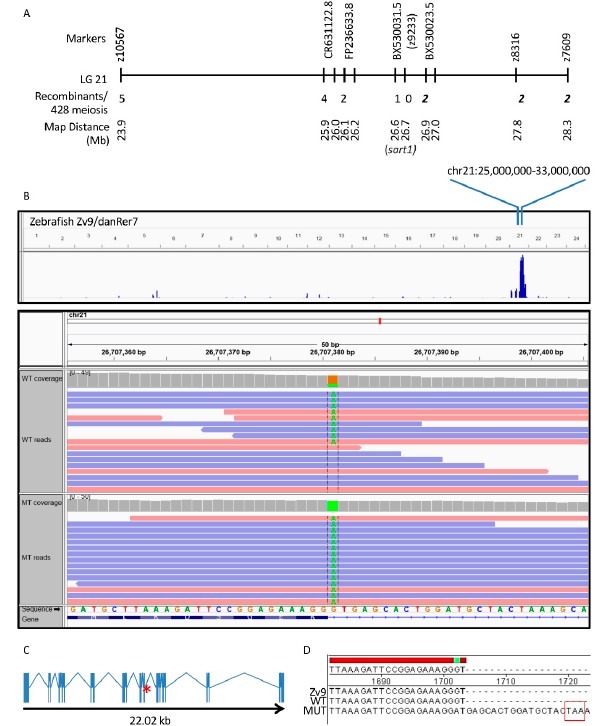
Figure 2. Positional cloning defines critical interval on chromosome 21 and WES identifies a point mutation in sart1 . ( A ) A critical interval was defined on Chromosome 21 using positional cloning. For bulked segregant analysis, the polymorphic marker z9233 demonstrated linkage having zero recombinants identified out of 450 meiotic events. Additional markers were analyzed both proximal and distal to z9233 to define a critical interval of approximately 0.4 Mb. The numbers of recombinants on the proximal side are shown in regular type and those distal to z9233 are shown in bold italic font. sart1 lies within the contig sequence BX530031.5. In ( B ), the blue peak is representative of the highest homozygosity score where mutants are homozygous within this defined loci along Chromosome 21. This finding is further demonstrated in the panel below where the reference genome contains a guanine (G) (in orange) at this position and all mutants have an adenine ( A ) (in green). An adenine is present in a portion of the wild-type sequence due to the fact that wild-type siblings may be heterozygous for the mutation. ( C ) shows that sart1 contains a point mutation at the end of exon 12 (red asterisk). ( D ) DNA Sanger Sequencing of cp27.5 wild-type and mutant cDNA confirms the G → A transition and reveals the retention of intron 12 and introduction of a premature stop codon